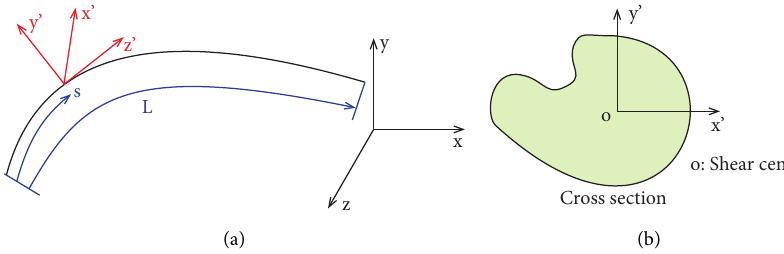
Figure 2: Illustrations of the coordinate systems for (a) an arbitrary curved beam and (b) its cross